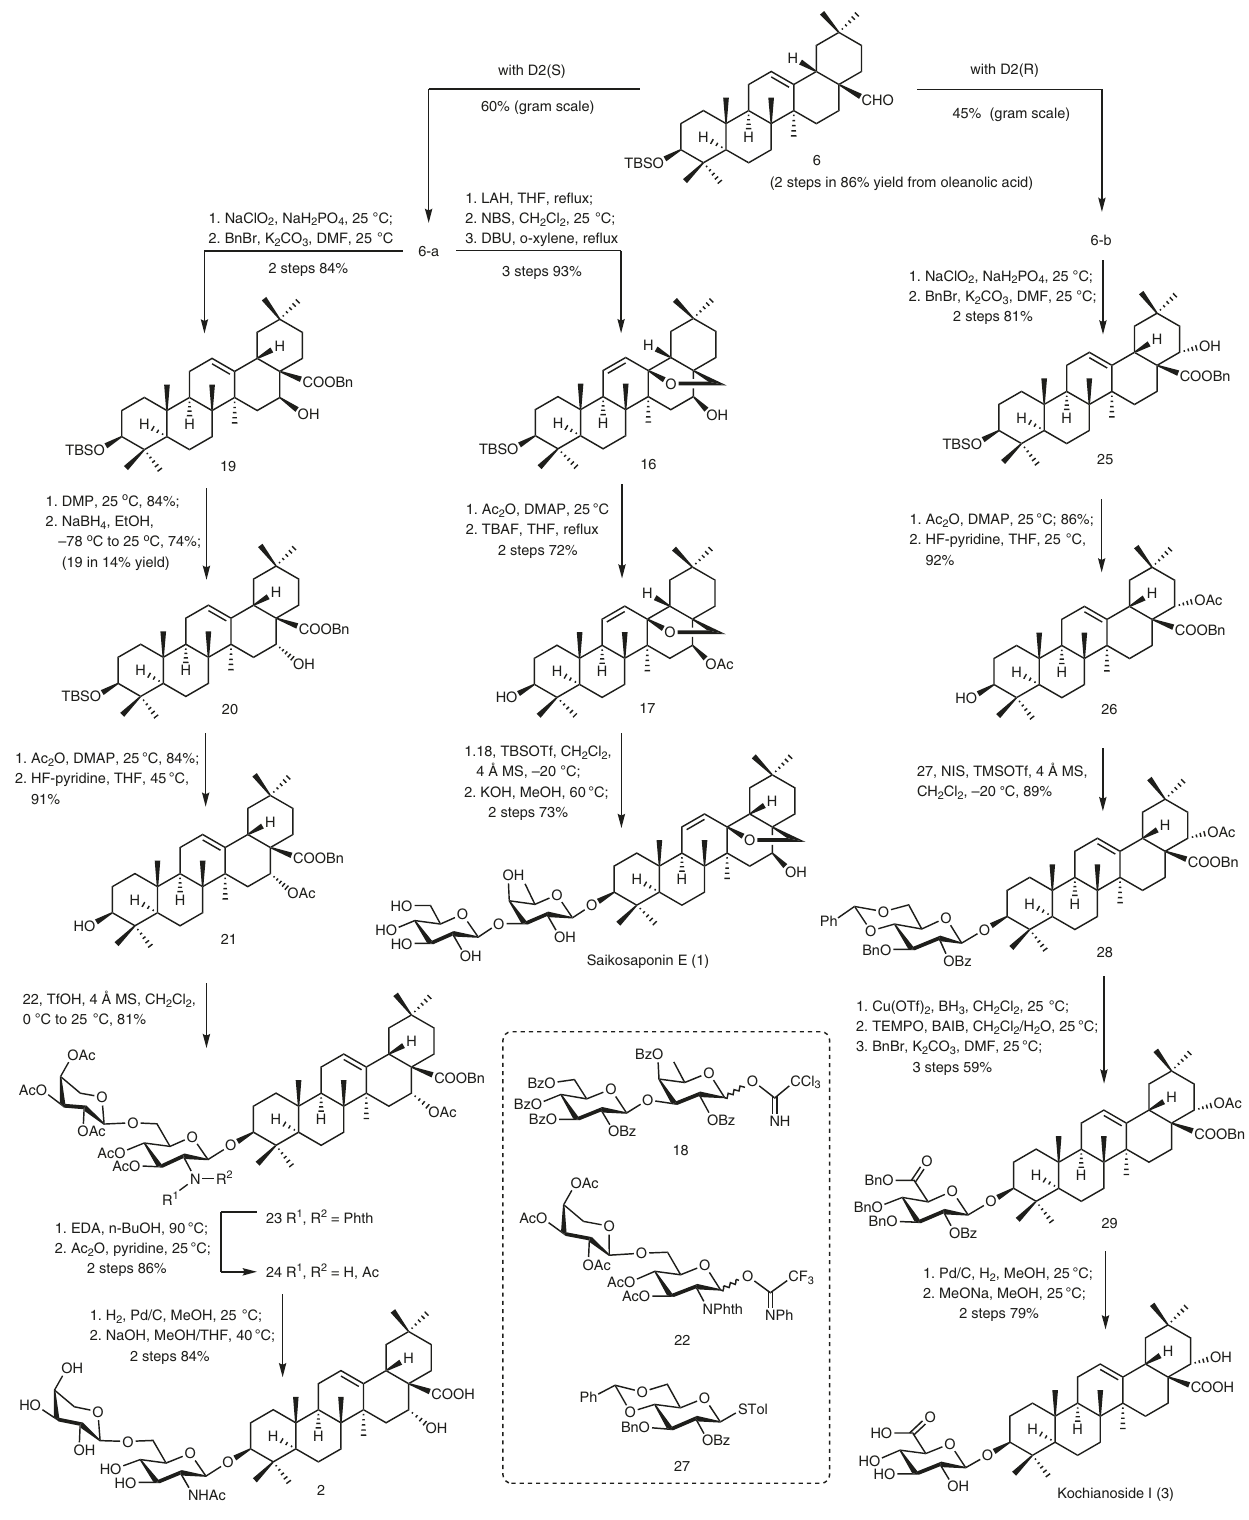
Fig. 4 Synthetic applications. Expeditious synthesis of Saikosaponin E ( 1 ), Albizia saponin 2 , and Kochianoside I ( 3 ). BAIB (diacetoxyiodo)benzene, Bn benzyl, DBU 1,8-diazabicyclo[5.4.0]undec-7-ene, DMAP 4-dimethylaminopyridine, DMF N , N -dimethylformamide, DMP Dess-Martin periodinane, EDA ethylenediamine, LAH lithium aluminum hydride, MS molecular sieves, NBS N -bromosuccinimide, NIS N -iodosuccinimide, Phth phthaloyl, TBAF tetrabutylammonium fl uoride, TEMPO 2,2,6,6-tetramethylpiperidinooxy, THF tetrahydrofuran, TMS